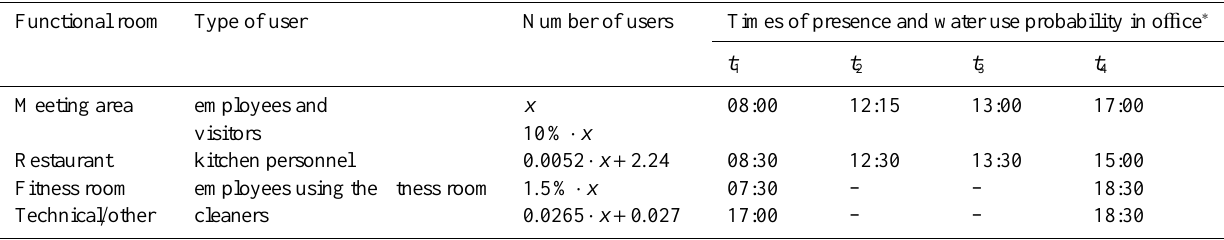
Table 4. Number of users and their water use probability in each functional room in a standardised o ffi ce as function of the dominant variable, x the number of employees.